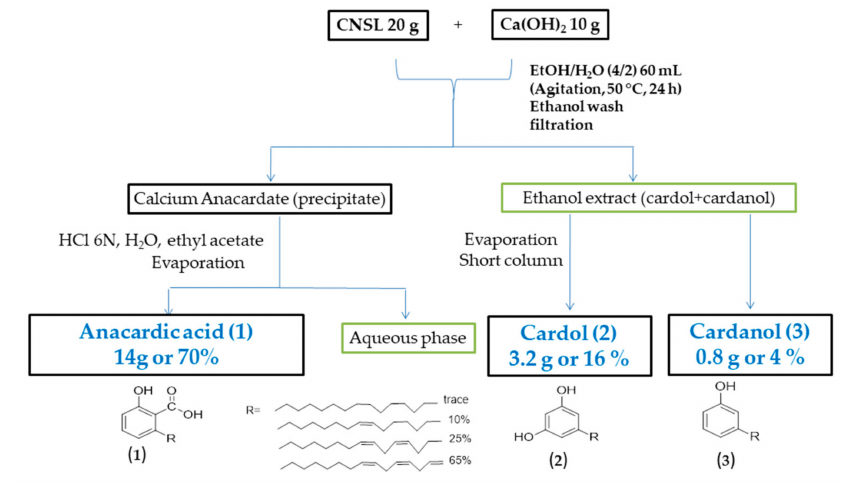
Figure 1. CNSL constituents